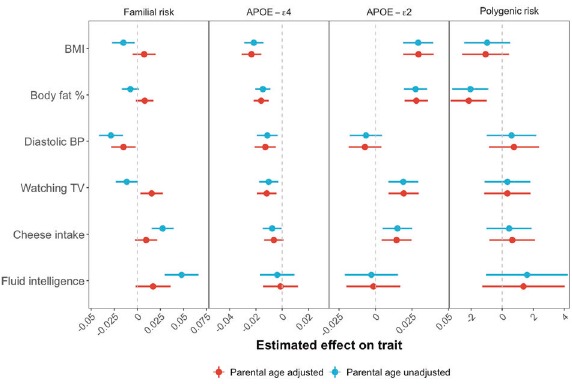
Fig. 4 Effect of parental age adjustment in different forms of AD genetic risk. Estimated effects (standardized) of familial risk, APOE- ε 4, APOE- ε 2, polygenic risk on selected traits using the primary analysis model (Fig. 1, see Methods), with or without adjustment of parental age. Points show effect size estimates and whiskers show 95% con fi dence